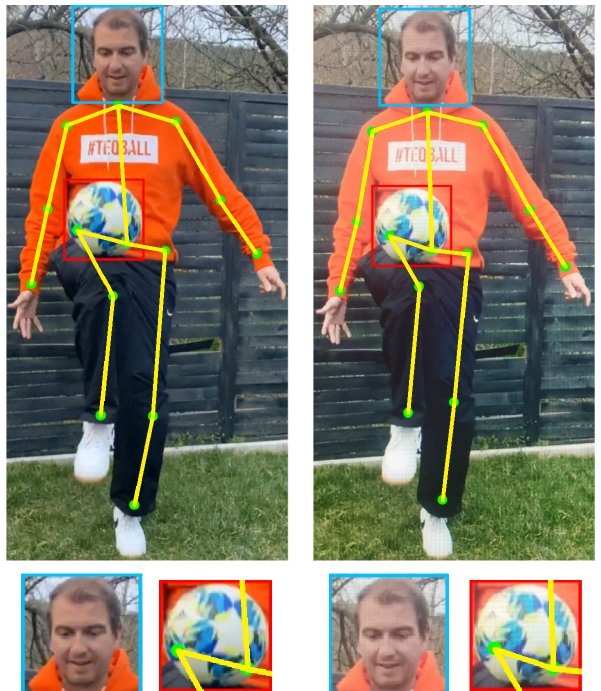
Figure 1. A sample event detection in a digital football game—the user hits the ball with the right knee. Top row: left—detection on a single frame of a video that captured a real user, right—detection on the same frame of the same video captured on a computer monitor (fake user). Bottom row left to right: close-ups of the detected head and football of real and fake users